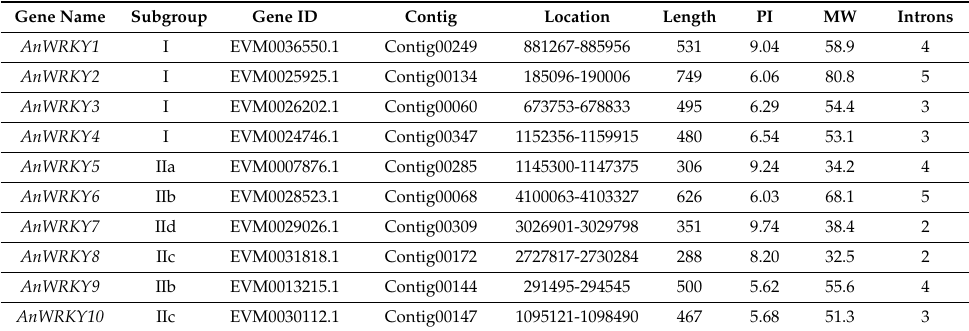
Table 1. A. nanus WRKY genes and their